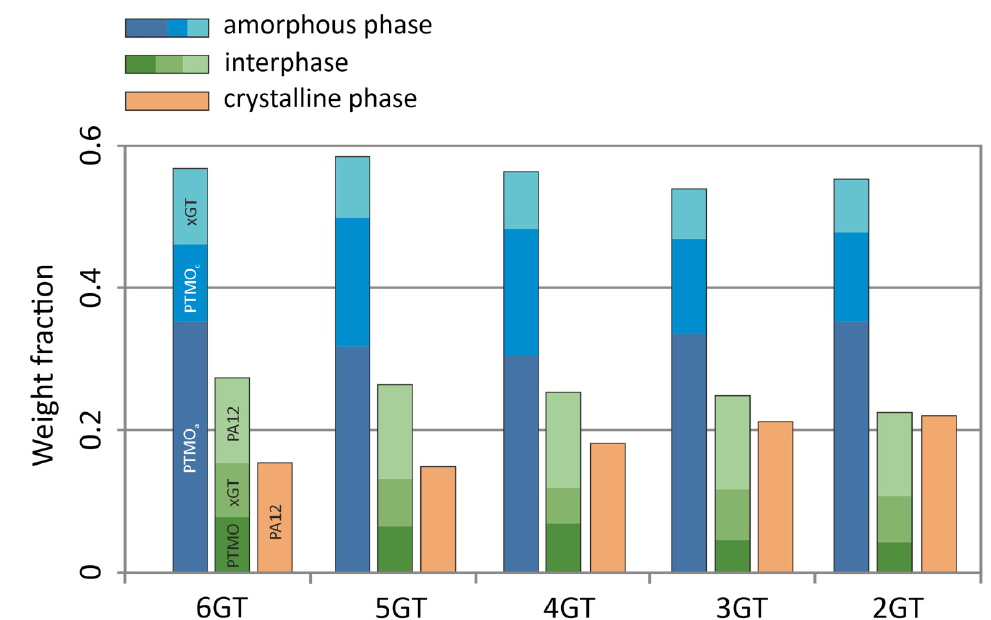
Figure 12. The phase compositions of the terpolymers of series I.